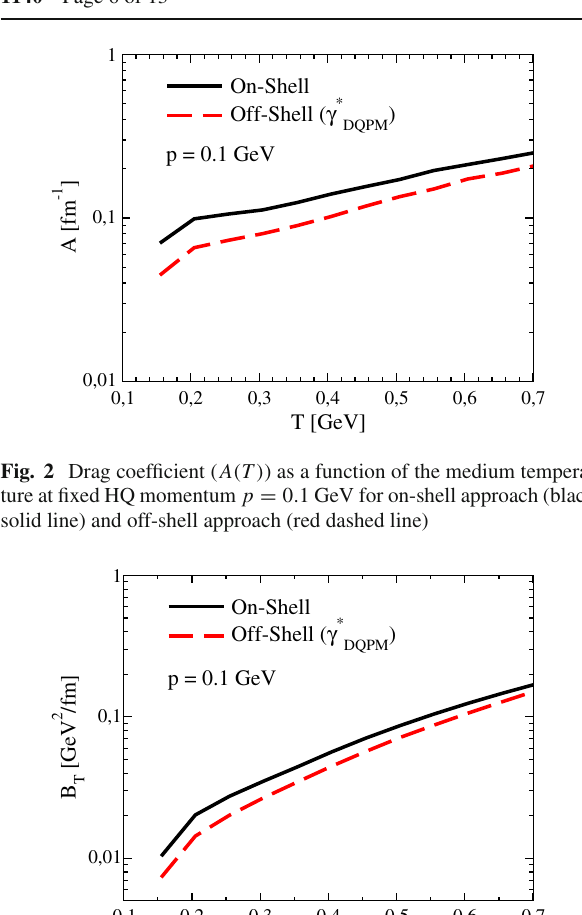
N s = 3 × 10 8 for the off-shell one. In Figs. 2 and 3 we com- pare the transport coefficients as a function of the medium temperature with a fixed HQ momentum of p = 0 . 1 GeV/c for the two different approaches studied in this paper. Solid lines refers to on-shell calculations while red dashed lines